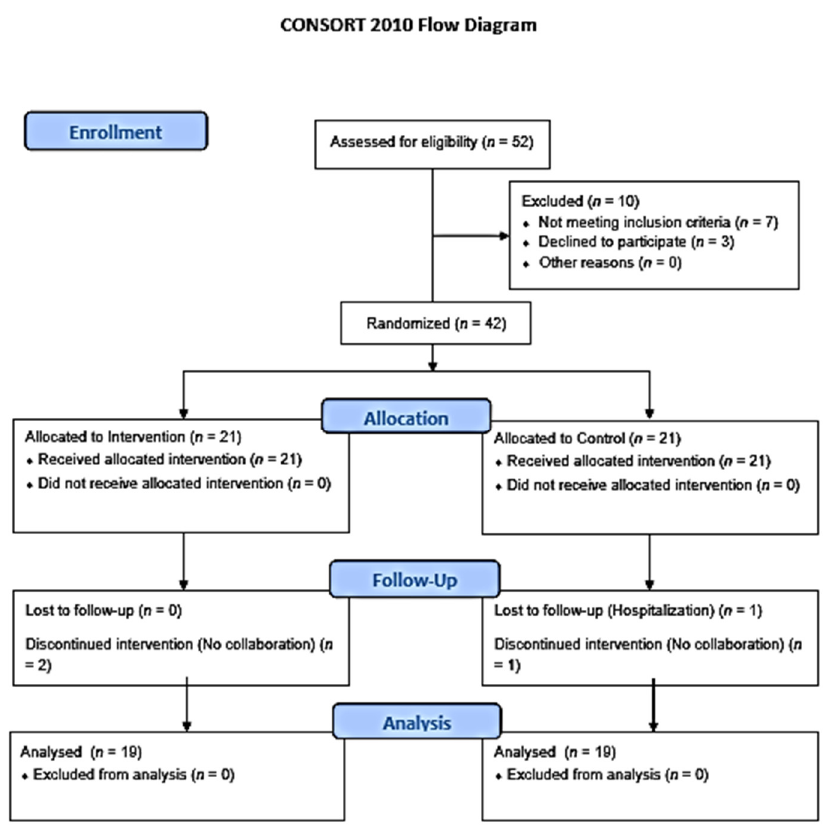
Figure 1. CONSORT flow diagram.